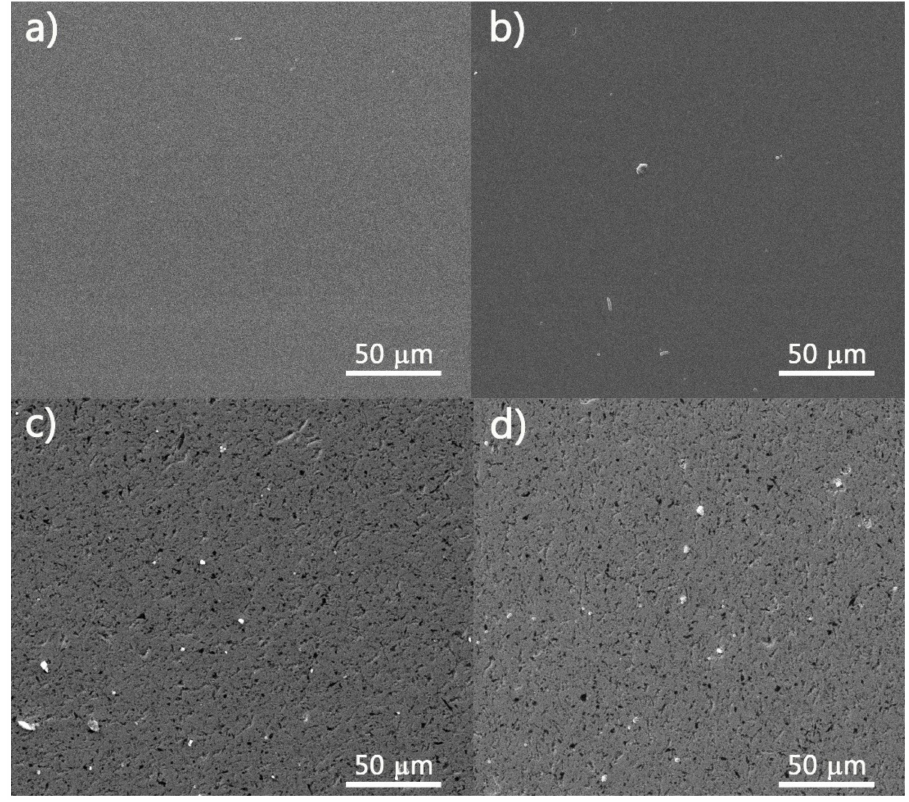
Figure 2. SEM images of the Be-D co-deposited layers: ( a ) D2 Si; ( b ) D20 Si; ( c ) D10 W; ( d ) D20